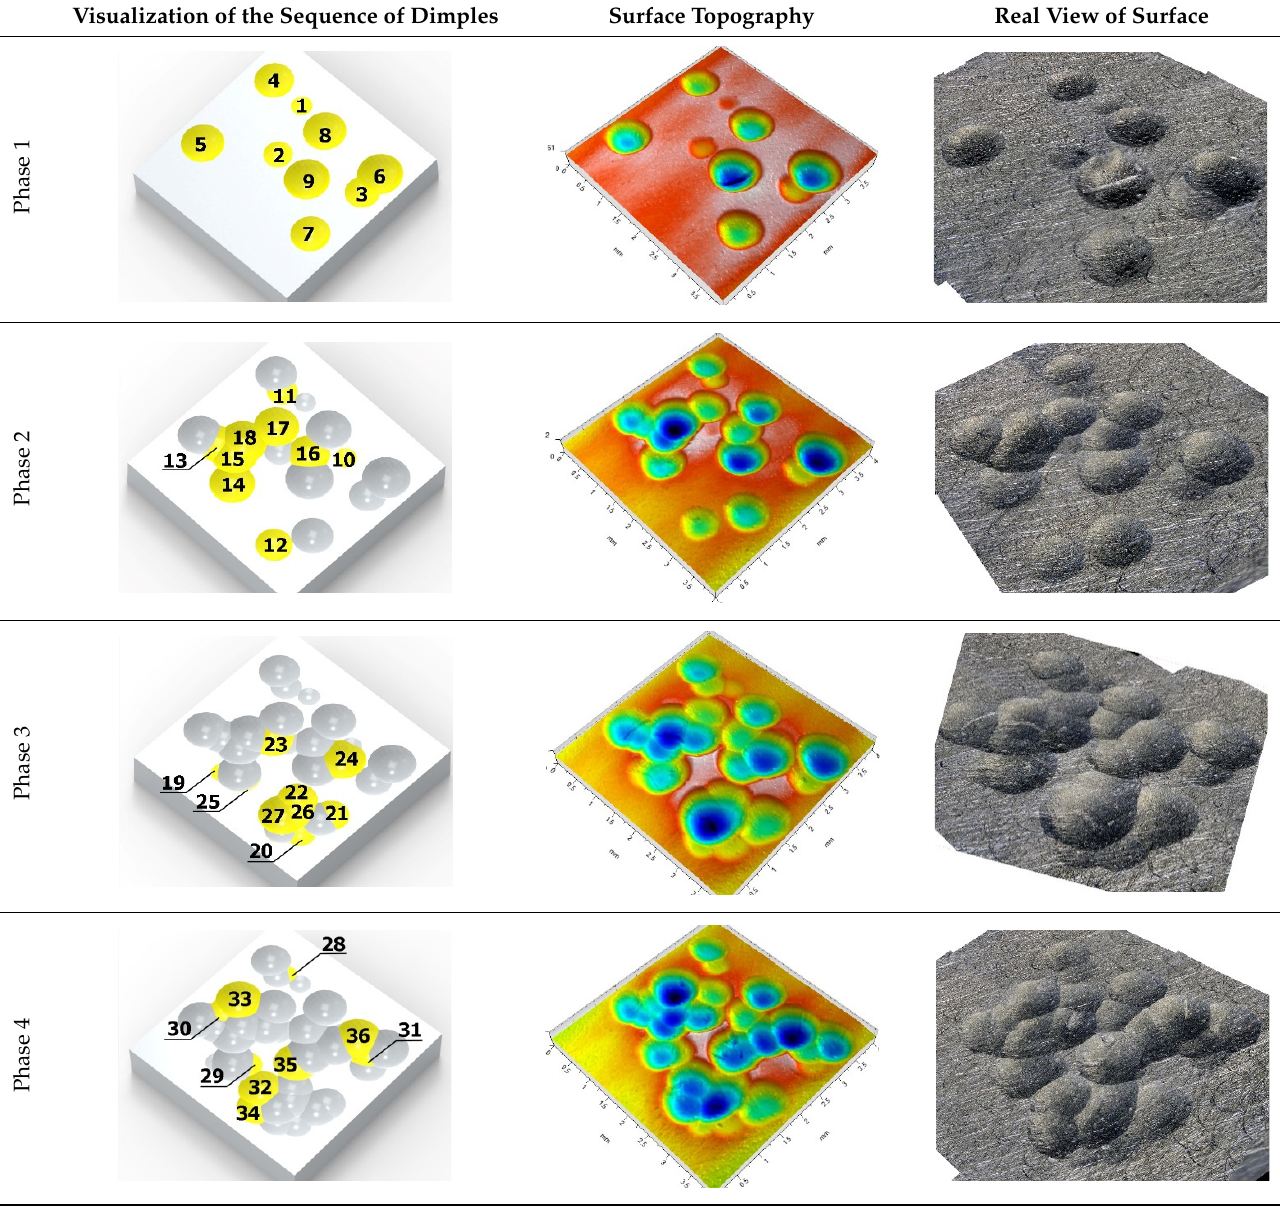
Table 1. Methodology of exerting a random sequence of impacts in vibratory peening. Visualization of the Sequence of